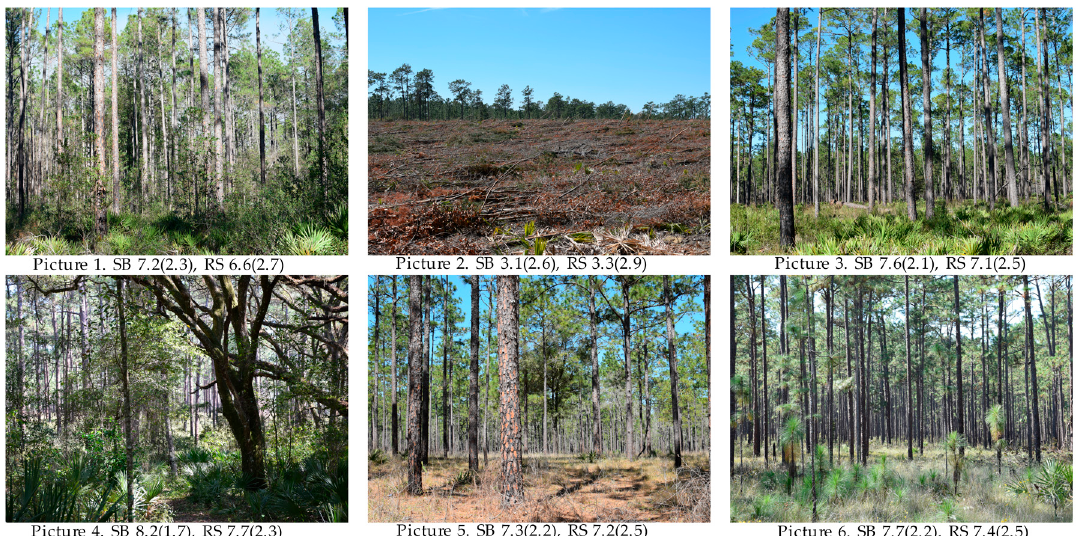
Figure 1. Photographic images used for scenic beauty and recreation satisfaction ratings of adult outdoor recreation users in Ocala National Forest, USA. SB: scenic beauty, RS: recreation satisfaction, values in ( ) indicate standard deviation. Pictures 3, 5, and 6 represent a good red-cockaded woodpecker (RCW) habitat and pictures 1, 2, and 4 represent a poor RCW habitat in the current state, as voted by the panel of six silviculture and RCW habitat